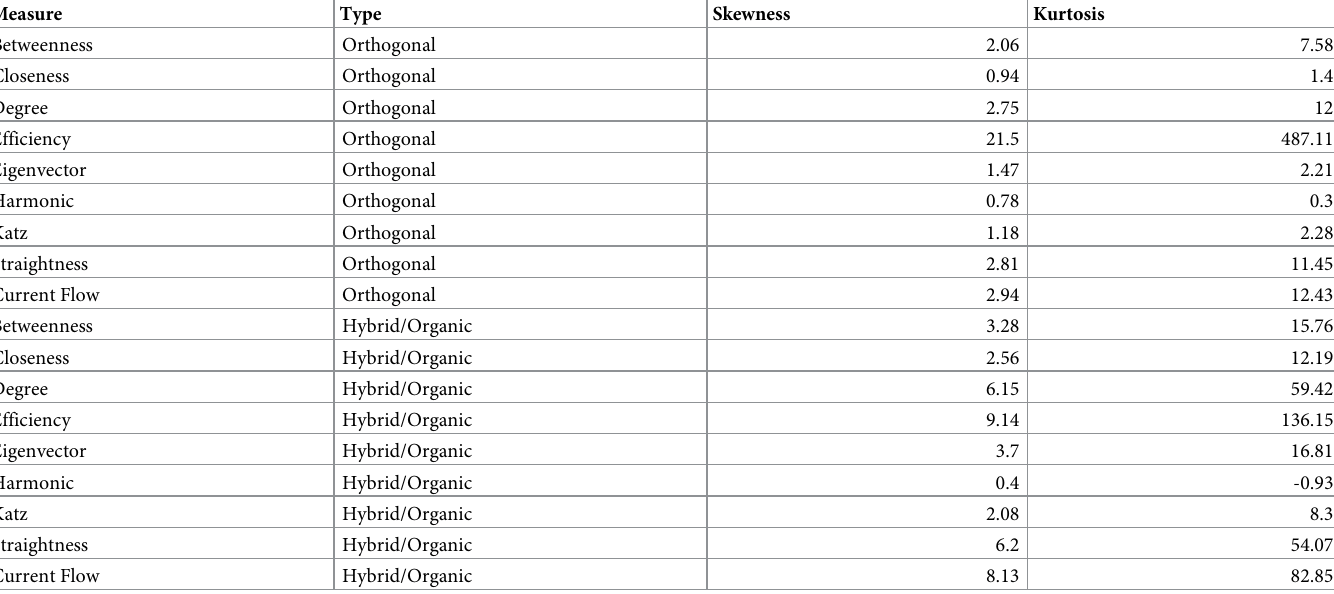
Table 1. Results demonstrating skewness and kurtosis for centrality distributions in different settlement